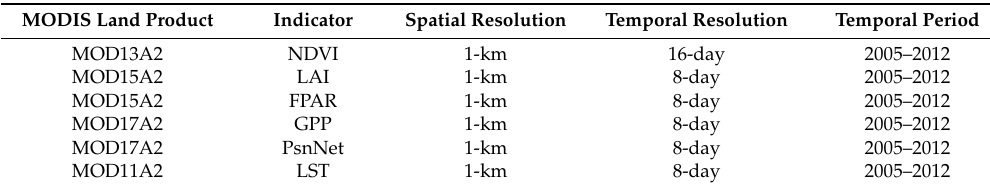
Table 1. Satellite data used in this